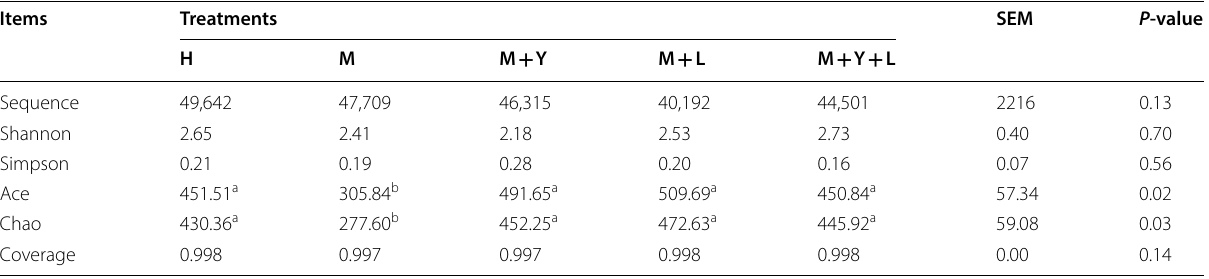
Table 3 Diversity indices and richness estimators of the 16rRNA gene libraries in milk microbiota of dairy cows in different treatments